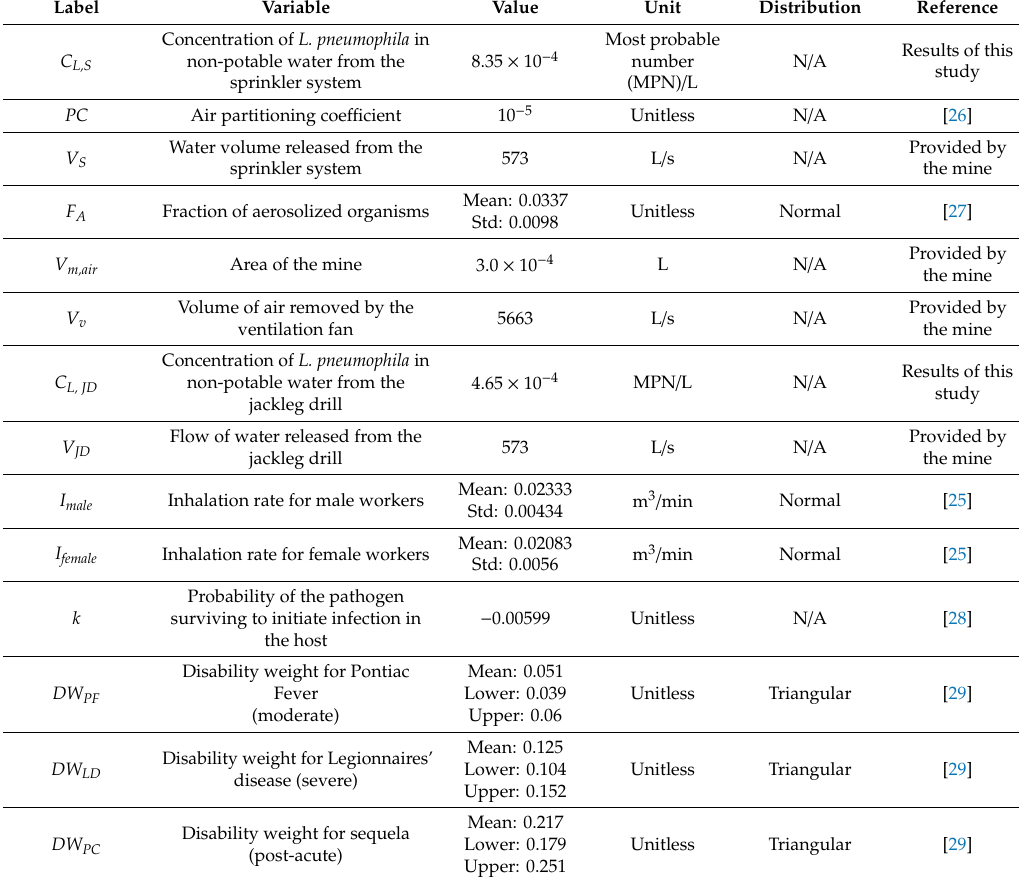
Table 1. Parameters used in the quantitative microbial risk assessment (QMRA)